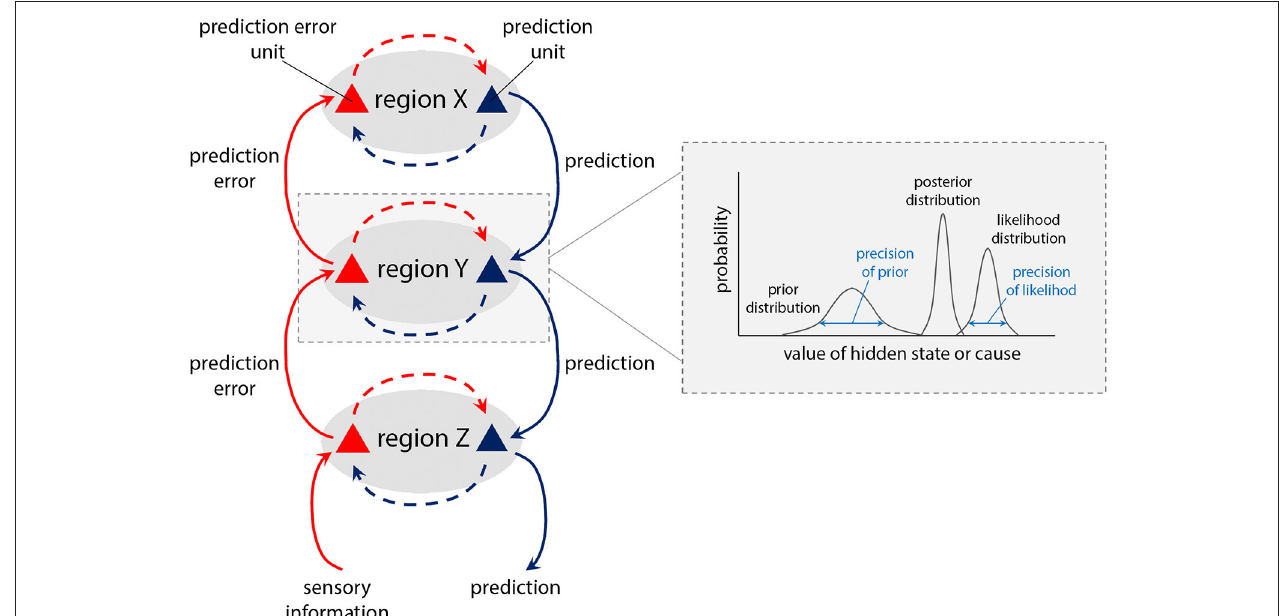
FIGURE 2 | Schematic of predictive coding within a hierarchical neural system (1, 2). Descending (blue) pathways convey ( prior ) predictions about the causes of sensory inputs, while ascending (red) pathways convey sensory (likelihood) prediction errors , which are combined at each level through generative models encoding prior and likelihood functions, to form (Bayesian) posterior expectations. The relative contributions of prediction and prediction error are weighted according to their (expected) precision, or “reliability” (see box), which is associated with the activity of neuromodulatory systems. Such neuromodulators can typically act to attenuate or amplify the effect of a pre-synaptic neuron on its post-synaptic target, hence attenuating or amplifying descending prior or ascending prediction error signals (“post-synaptic